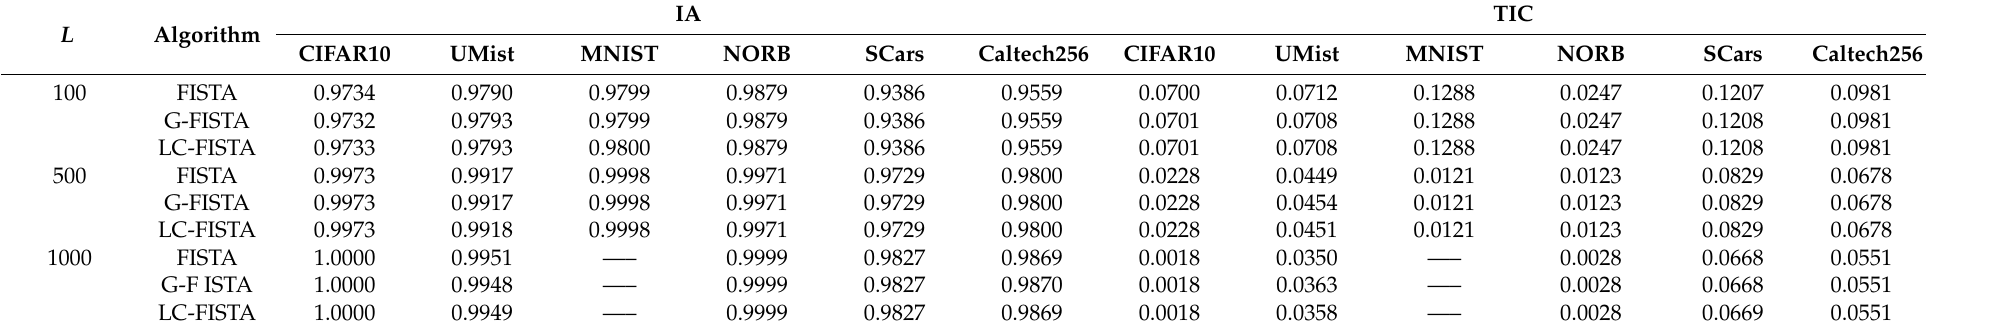
Table 6. IA and TIA values achieved by FISTA, G-FISTA and LC-FISTA for training of the